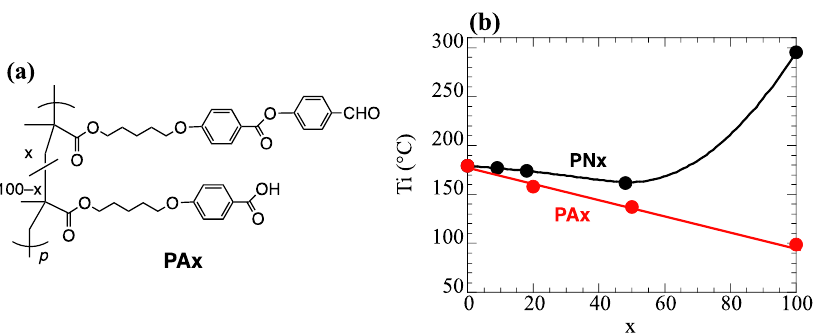
Figure 9. ( a ) Chemical structure of LC copolymers PAx . ( b ) T i of copolymers as a function of copolymer composition.